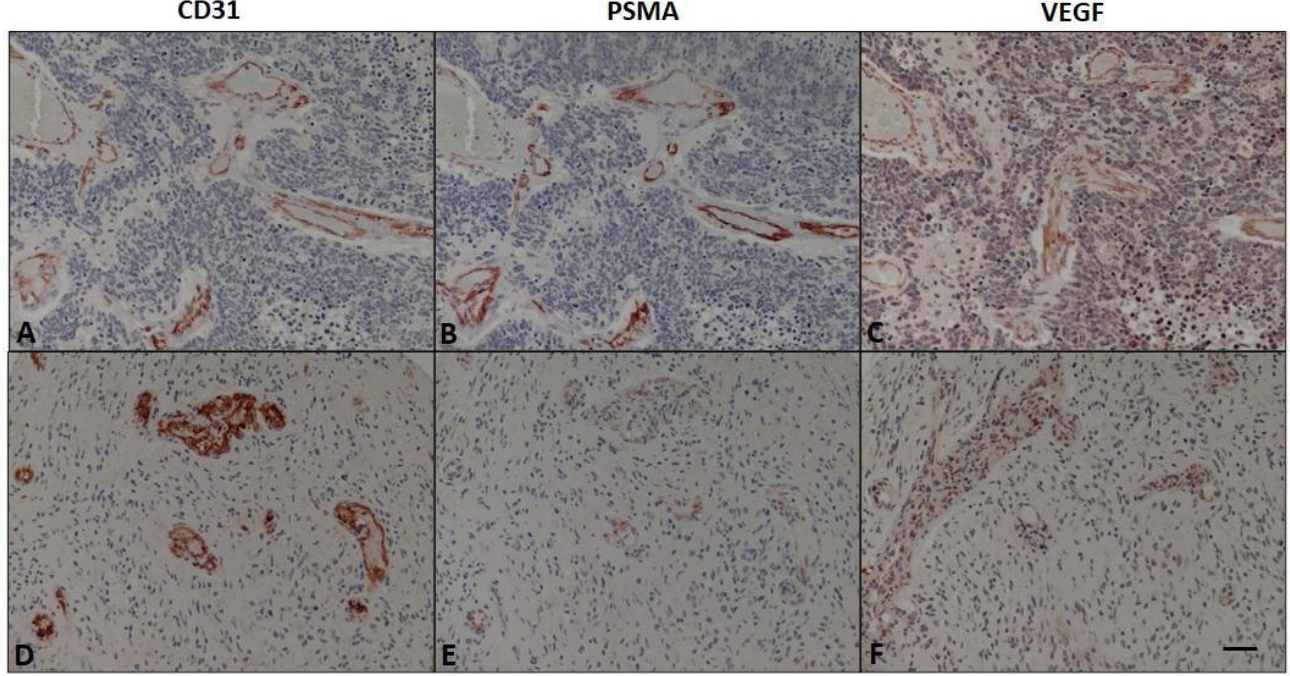
Figure 1. Immunohistochemical stains of vascular endothelial expression. ( A , D ): CD31 staining of vessels for reference; ( B , E ): High and low PSMA expression, respectively; ( C , F ): High and low VEGF expression, respectively. Scale bar = 50 µm.